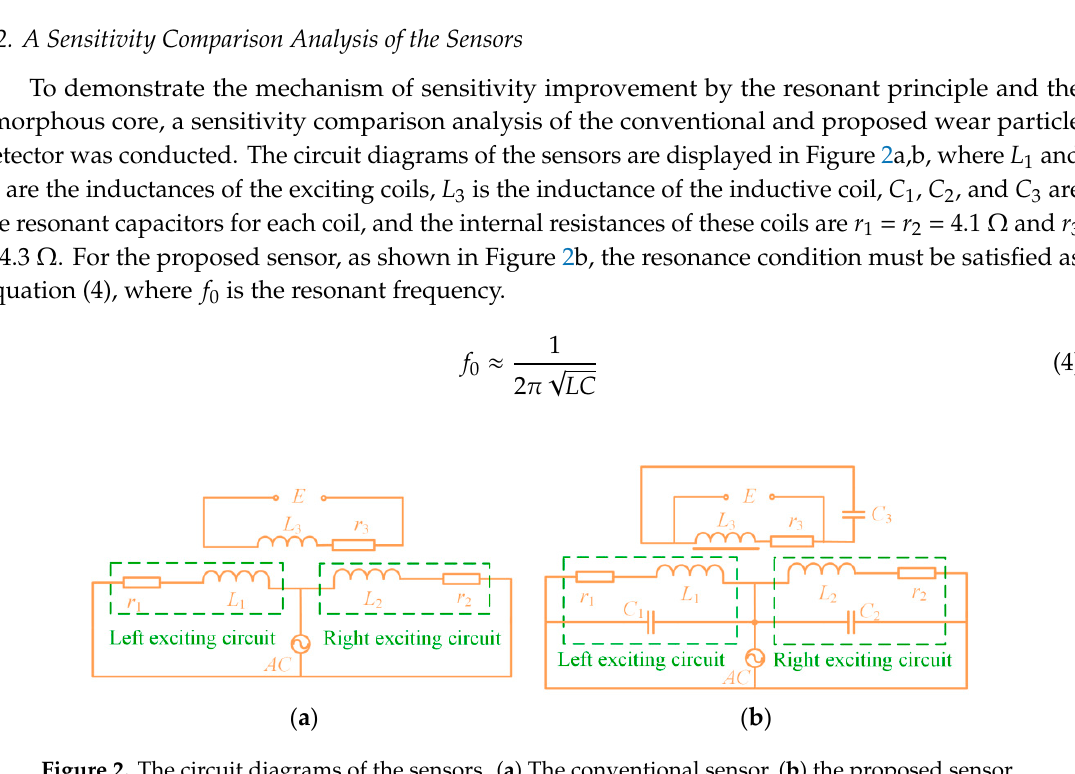
Figure 2. The circuit diagrams of the sensors. ( a ) The conventional sensor, ( b ) the proposed sensor.